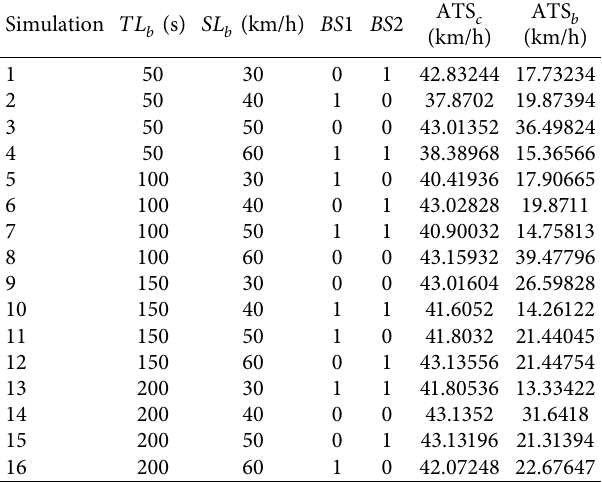
Table 2: Experiment 1